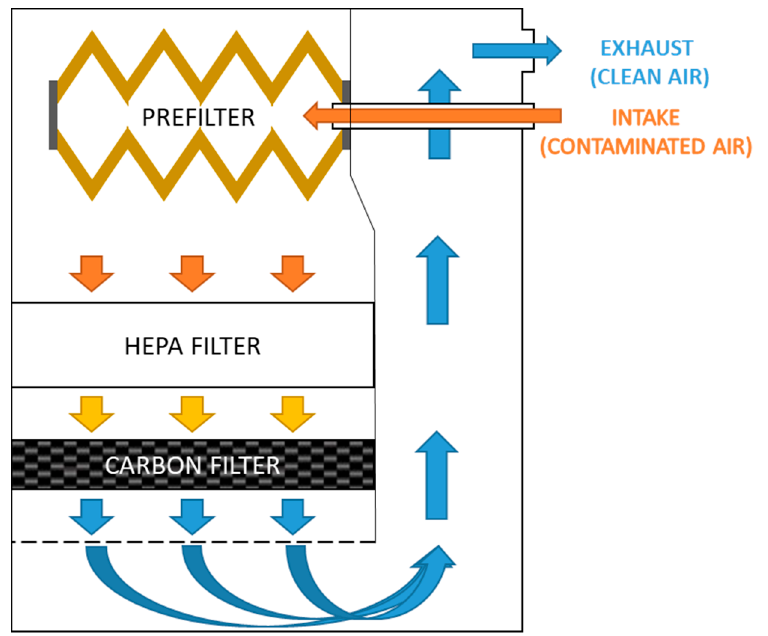
Figure 1. The scheme of typical filters used in the air cleaner (ACL) device.